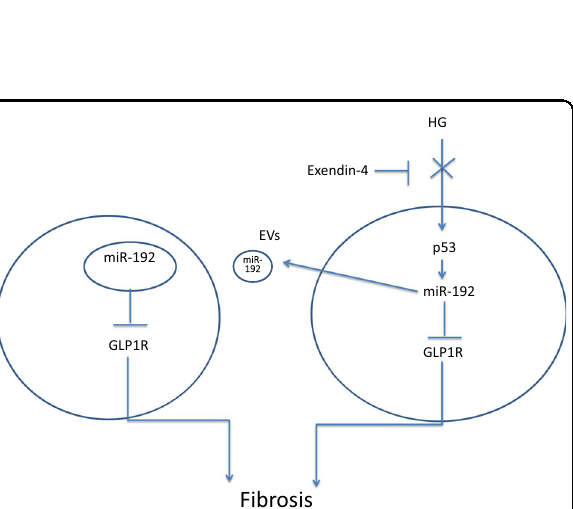
Fig. 9 Exendin-4 inhibited the transfer of miR-192 and protected renal cells. Exendin-4 inhibited the transfer of EV miR-192 from HG- induced renal tubular epithelial cells to normal cells in a p53- dependent manner, thus inhibiting GLP1R downregulation by miR- 192 and protecting renal